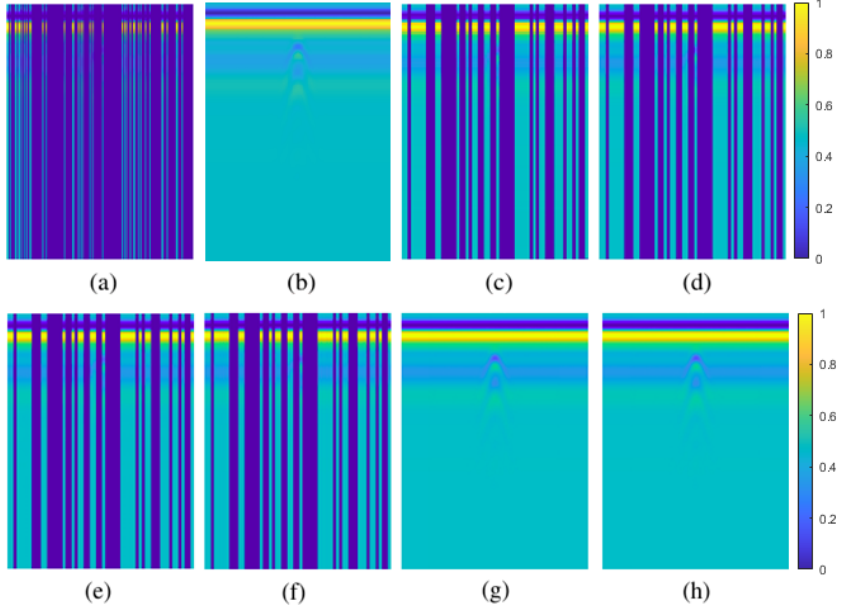
Figure 13. 80% column-wise missing data case for simulated data: ( a ) GPR image with missing entries, ( b ) original GPR image, recovered images by ( c ) GoDec, ( d ) NMC, ( e ) Lmafit, ( f ) NNM, ( g ) PEN-Net, ( h )